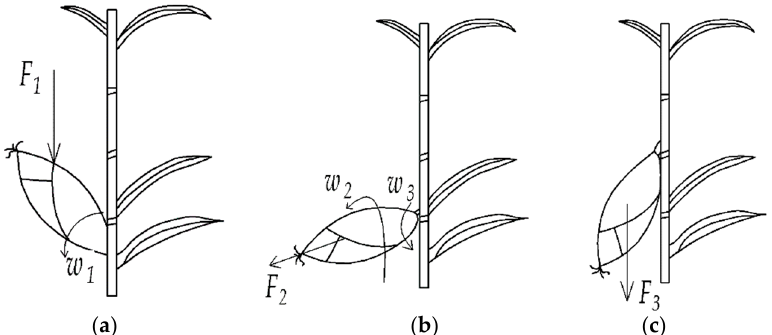
Figure 1. Principle of hand picking. ( a ) bending stage; ( b ) bending and twisting stage; ( c ) final stretching stage.